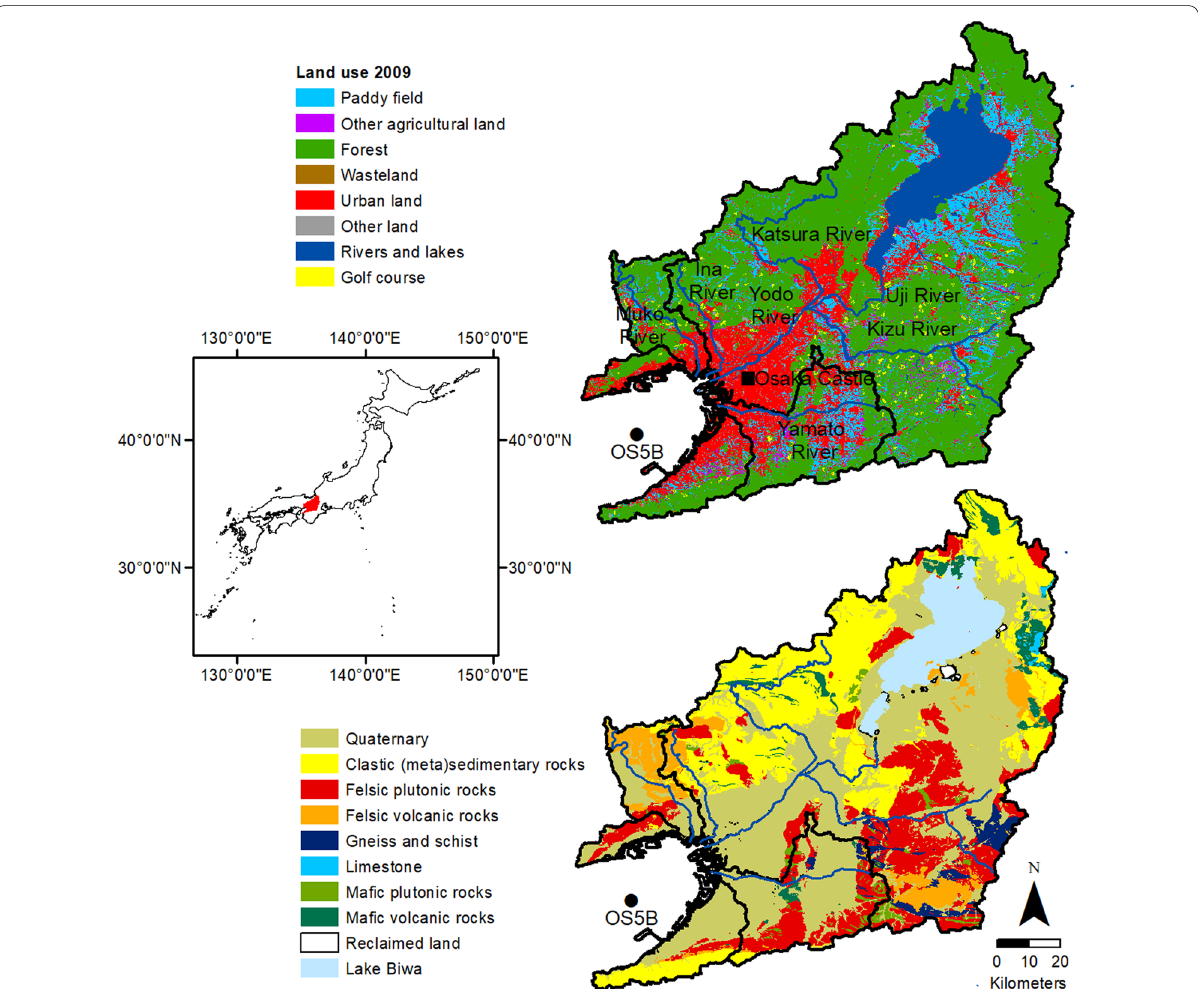
Fig. 1 Location of the Osaka Bay catchment in Japan (left). Geological map of the Osaka Bay catchment (top) and land-use map (bottom) with subbasins of the Yodo, Muko, and Yamato Rivers, other major rivers, the locations of the sediment cores collected at station KT-11-13 OS5B, and of Osaka Castle. The geological information was obtained from the Seamless Geological Map (Geological Survey of Japan 2015). Land-use data were obtained from Land Use Fragmented Mesh Version 2.5.1 from the National Land Numerical Information, created by Ministry of Land,